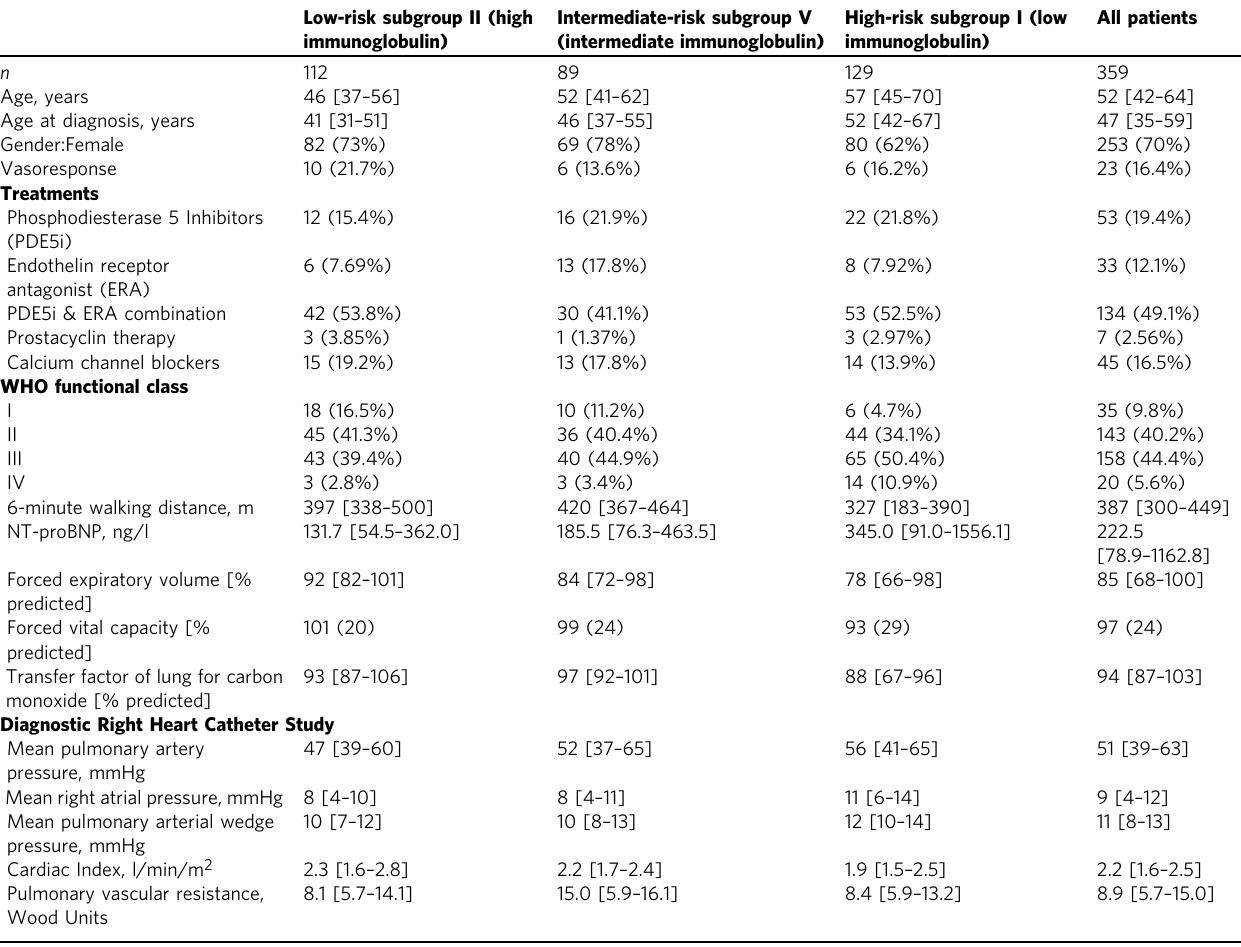
Table 1 Major clinical characteristics of the three main RNA subgroups in the discovery cohort ( n = 359) at the time of